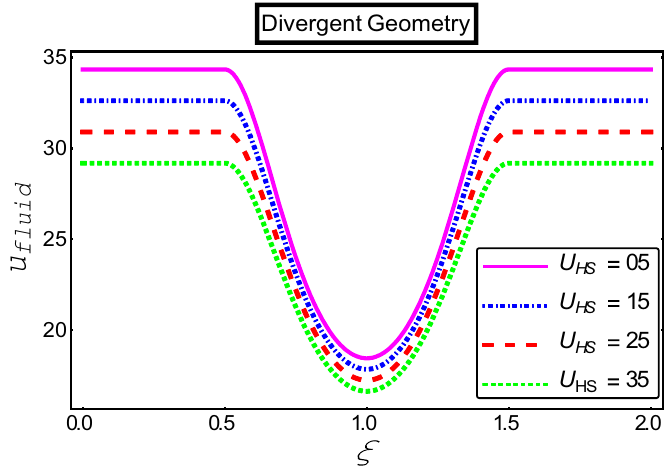
Figure 14. Impact of Helmholtz–Smoluchowski parameter on fluid velocity.